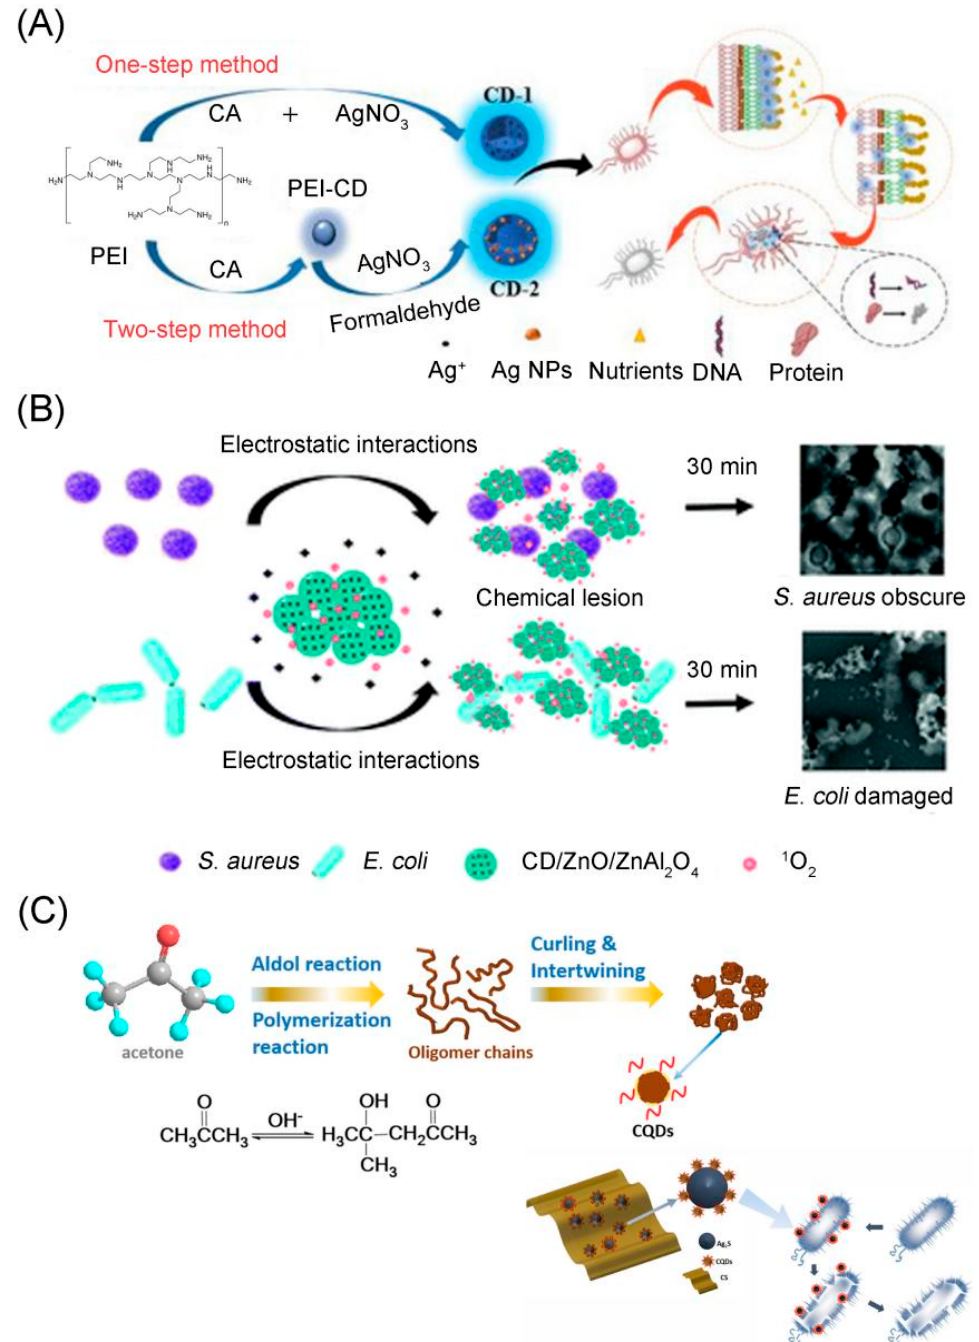
Figure 3. Metal-containing CDs for killing microorganims. ( A ) Scheme depicting the synthesis of CD-1 and CD-2, and their antibacterial properties. Reproduced with permission from [60]. Copyright 2021, Elsevier Inc. ( B ) Antibacterial mechanism of CD/ZnO/ZnAl 2 O 4 . Reproduced with permission from [68]. Copyright 2021, The Royal Society of Chemistry. ( C ) Scheme illustrating the formation of CQDs/Ag 2 S/CS and its antibacterial effect. Reproduced with permission from [71]. Copyright 2021, Elsevier Inc.